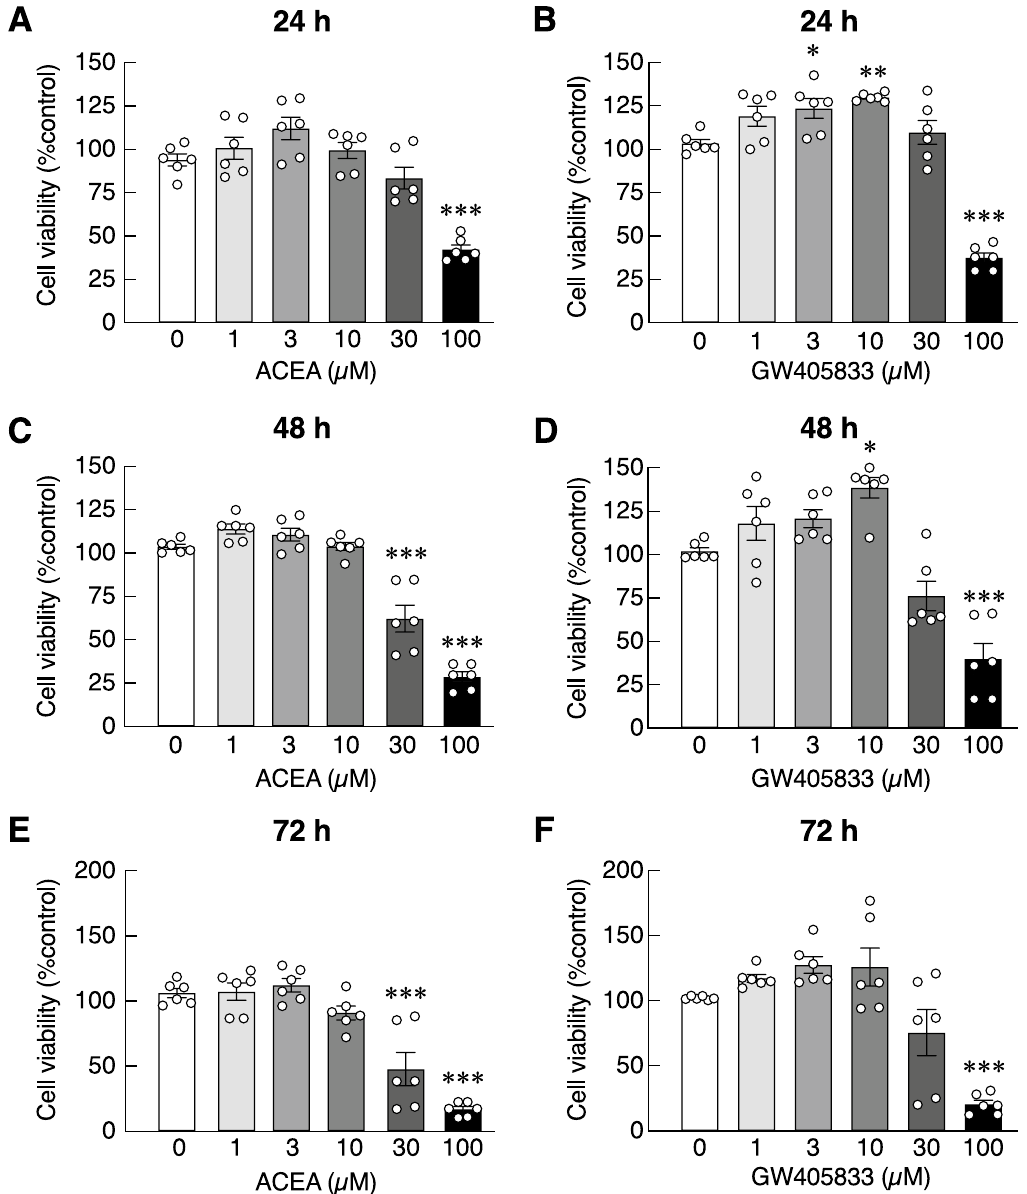
Figure 2. Cytotoxic effects of ACEA ( a – c ) and GW405833 ( d – f ) on UMR-106 cell viability were measured by MTT assay. Cells were treated with the compounds of various concentration (0–100 µM) for 24, 48 or 72 h. The results were expressed as mean ± SEM of three independent biological replicates with two technical replicates each. (*** p < 0.001, ** p < 0.01, * p <